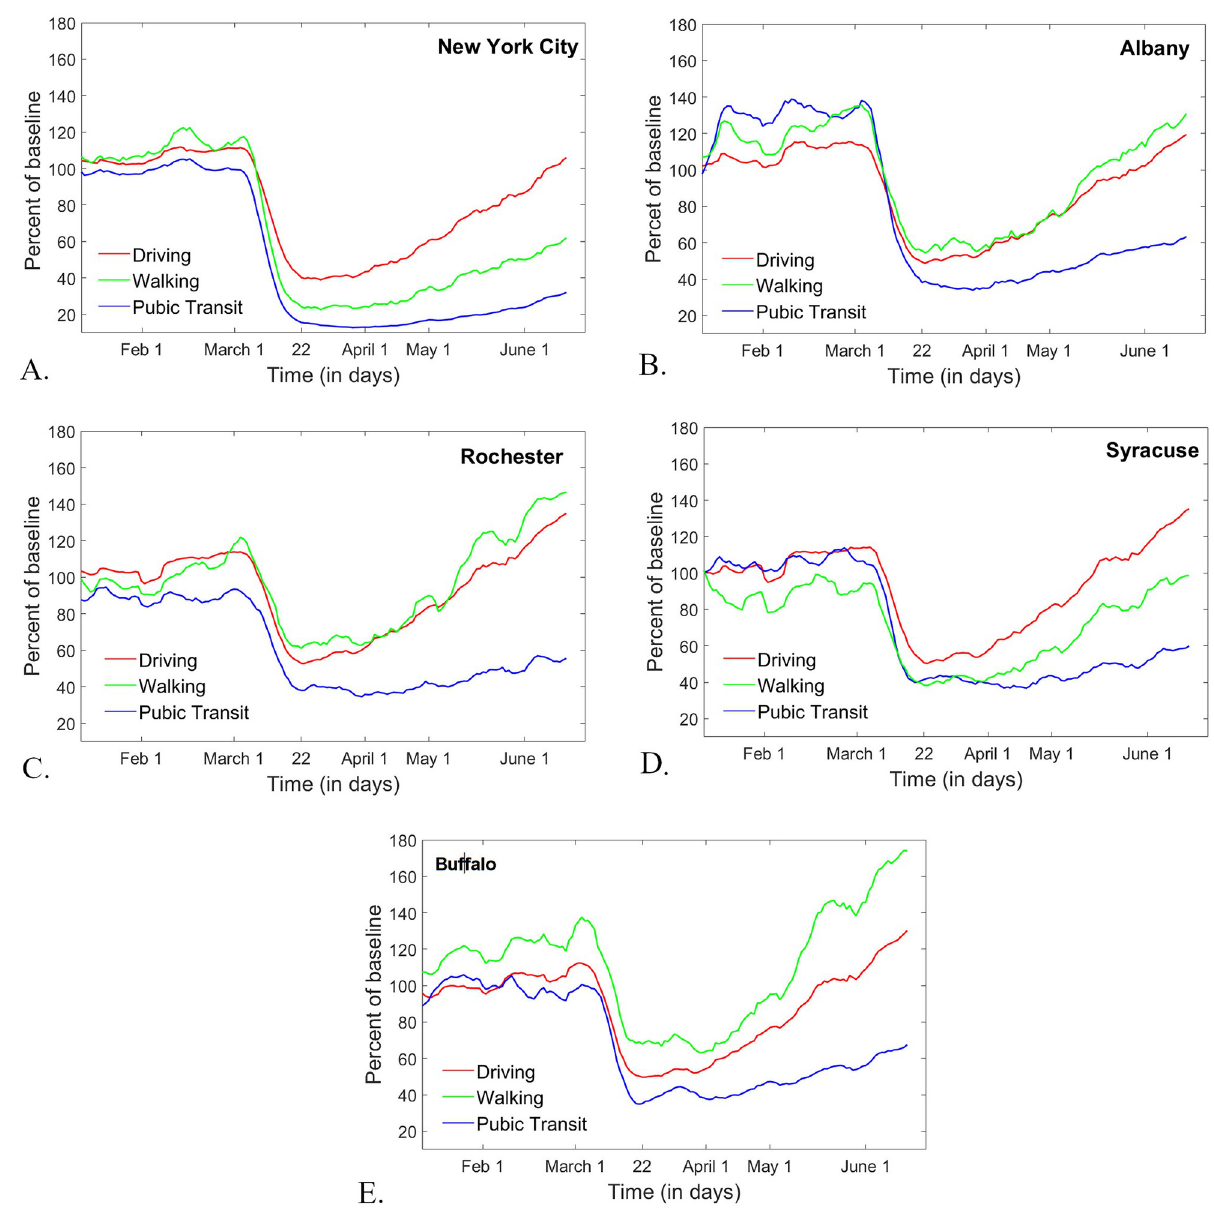
Fig 5. Trends in all traffic modalities (driving, walking and public transport) as per the Apple data set, for five metropolitan areas in New York State. A. New York City; B. Albany; C. Rochester; D. Syracuse; E. Buffalo. Driving patterns are shown as a red curve, walking in green and public transport in blue